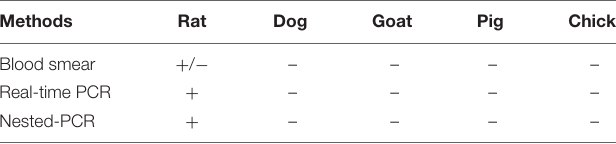
TABLE 1 | Blood detection of animals infected with B. microti in 2 month periods. Methods